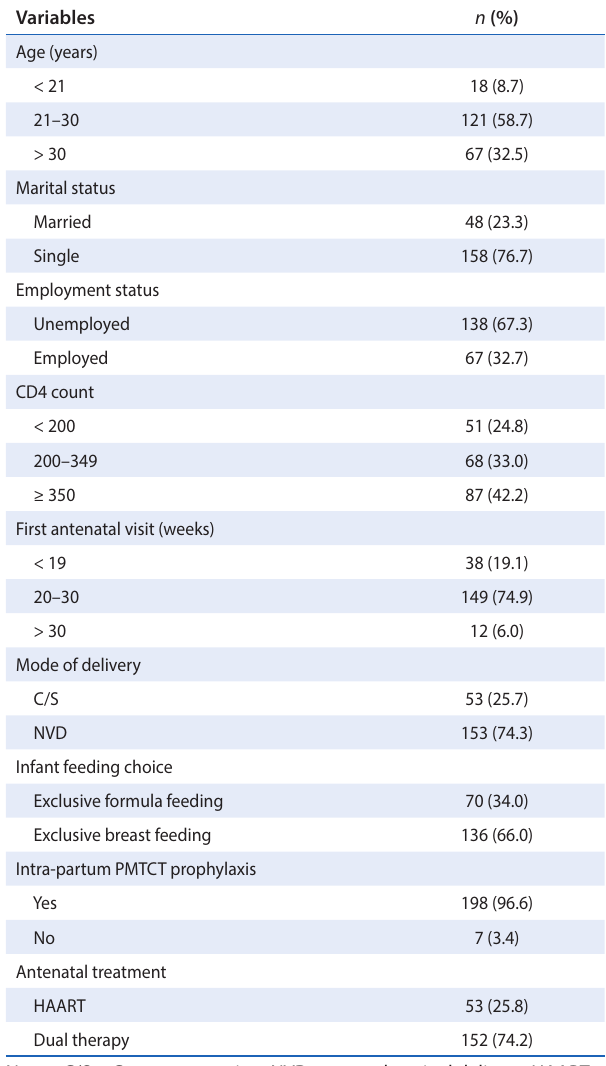
Table 1: Baseline characteristics of mothers ( n =